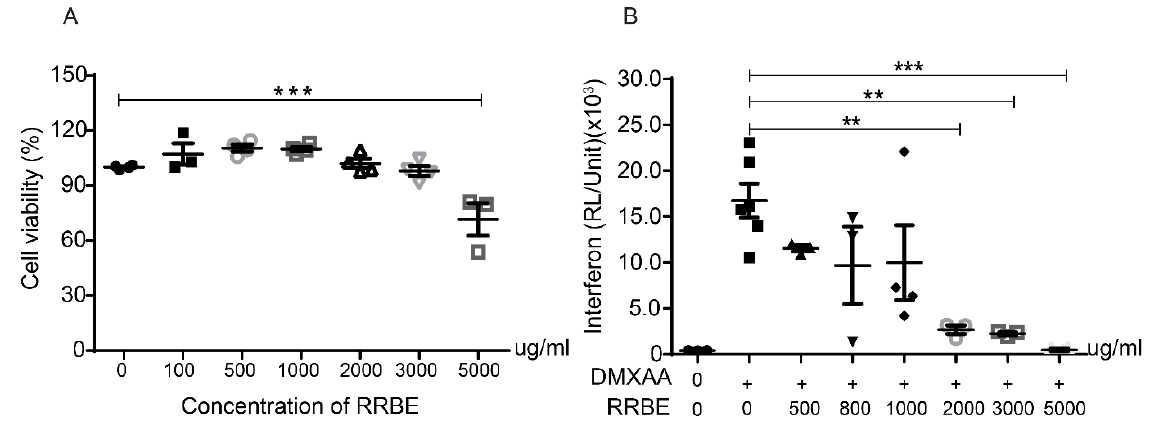
Figure 1. Effects of RRBE on the cytotoxicity and production of inflammatory cytokines. ( A ) The cytotoxic effects of different concentrations of RRBE were examined in comparison with the untreated group by an MTS assay (N = 3 – 4). ( B ) The levels of luciferase in the culture medium were determined by a luciferase detection reagent after DMXAA activation with and without RRBE for 24 h in RAW- Lucia™ ISG cells (N = 3 – 6). Data shown as mean ±SEM, ** p < 0.01, and *** p < 0.001.